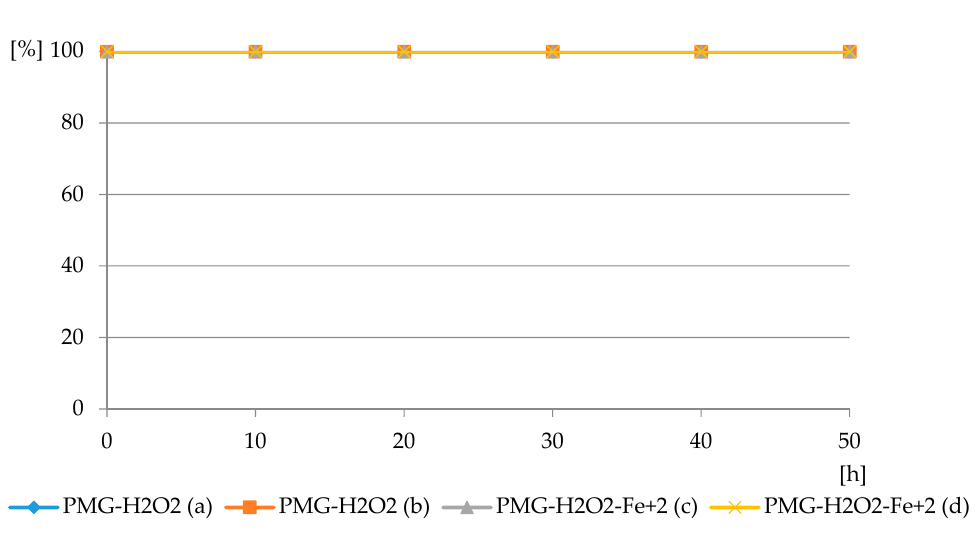
Figure 8. The profiles of PMG consumption in reaction with H 2 O 2 in PMG-H 2 O 2 and PMG- H 2 O 2 -Fe 2+ systems at pH =3.5: PMG:H 2 O 2 = 1:5 (PMG-H 2 O 2 (a)) and 1:10 (PMG-H 2 O 2 (b)); PMG:H 2 O 2 :Fe 2+ = 1:10:0.05 (PMG-H 2 O 2 -Fe 2+ (c)); and 1:10:0.1 (PMG-H 2 O 2 -Fe 2+ (d)) (residual PMG (%) vs. exposure time